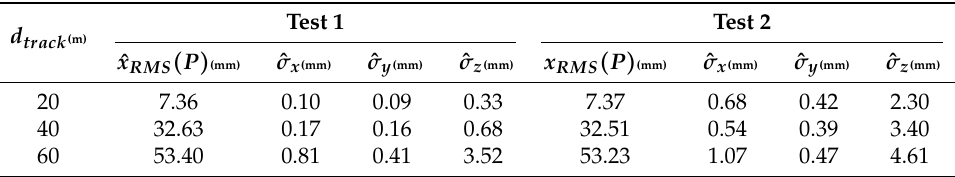
Table 6. Comparison of relative point accuracy x RMS ( P ) and standard deviation ˆ σ ( C ) without (motor shut off) and under heavy vibrations (motor